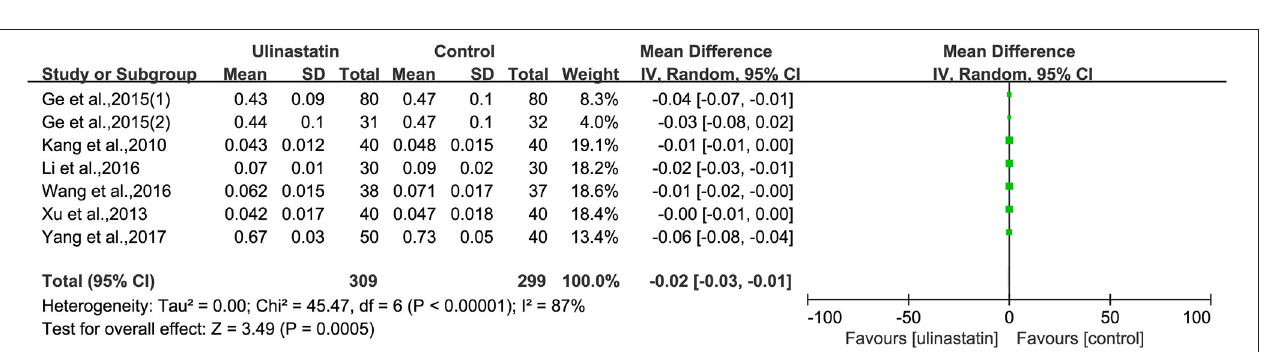
FIGURE 7 | Forest plot: Comparing plasma S100 β of patients receiving ulinastatin vs. control.